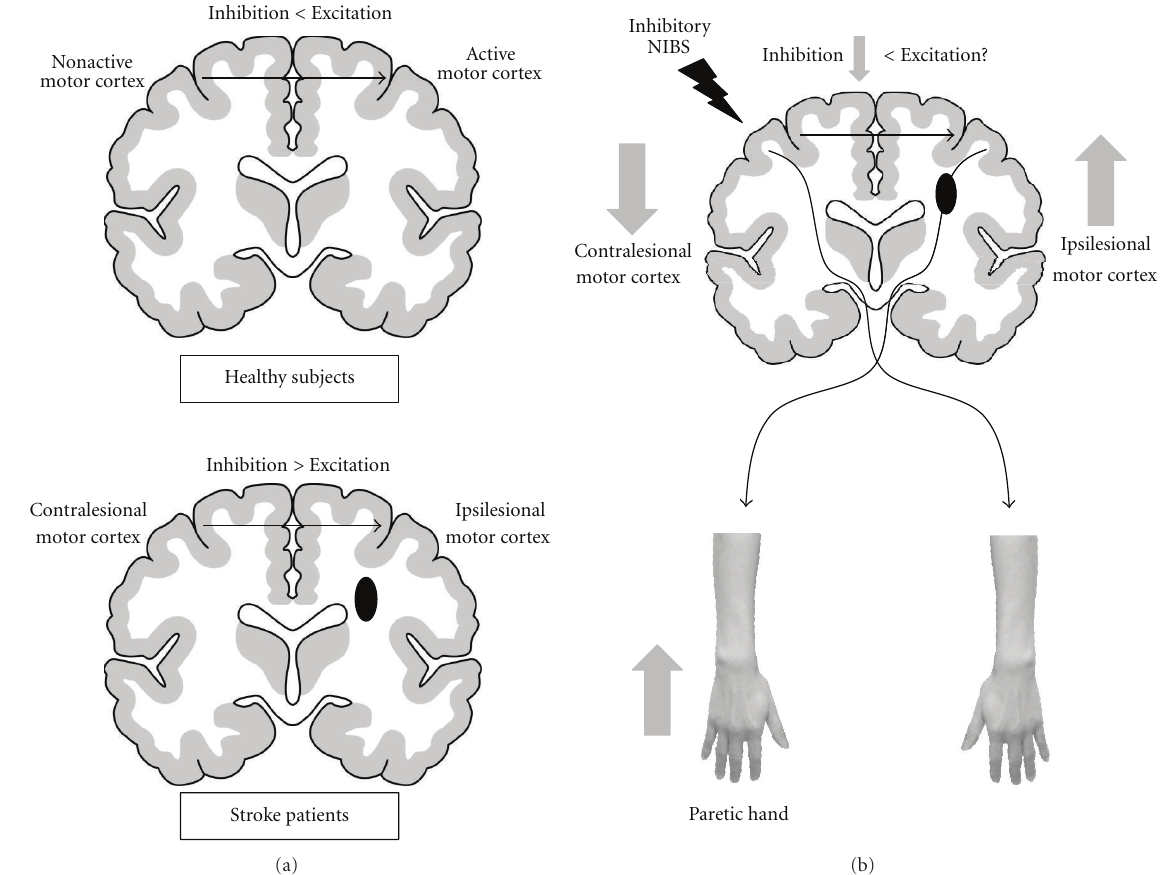
Figure 1: Changes in interhemispheric interaction and inhibitory noninvasive brain stimulation (NIBS) therapy in patients with subcortical stroke. (a) Mechanisms underlying the changes in interhemispheric interaction after stroke. In healthy subjects, the interhemispheric interaction changes from an inhibitory to an excitatory influence on the active motor cortex around movement onset. In contrast, stroke patients with motor deficits do not show this release from interhemispheric inhibition for the movement of the paretic hand; rather, they exhibit a persistent inhibitory influence on the ipsilesional motor cortex [34]. These pathological e ff ects contribute to the reduced performance of the paretic hand. (b) Inhibitory NIBS over the una ff ected hemisphere. Inhibitory NIBS decreases the excitability of the contralesional motor cortex and reduces the interhemispheric inhibition from the contralesional to the ipsilesional motor cortex. The excitatory interhemispheric interaction from the contralesional to the ipsilesional motor cortex might be relatively strong because of a reduced inhibitory influence. The change in interhemispheric interaction after inhibitory NIBS increases the excitability of the ipsilesional motor cortex. Facilitation of the ipsilesional motor cortex improves the motor function of the paretic hand in patients with subcortical stroke [99, 115]. However, it remains to be determined whether the excitatory interhemispheric interaction itself actually changes after inhibitory